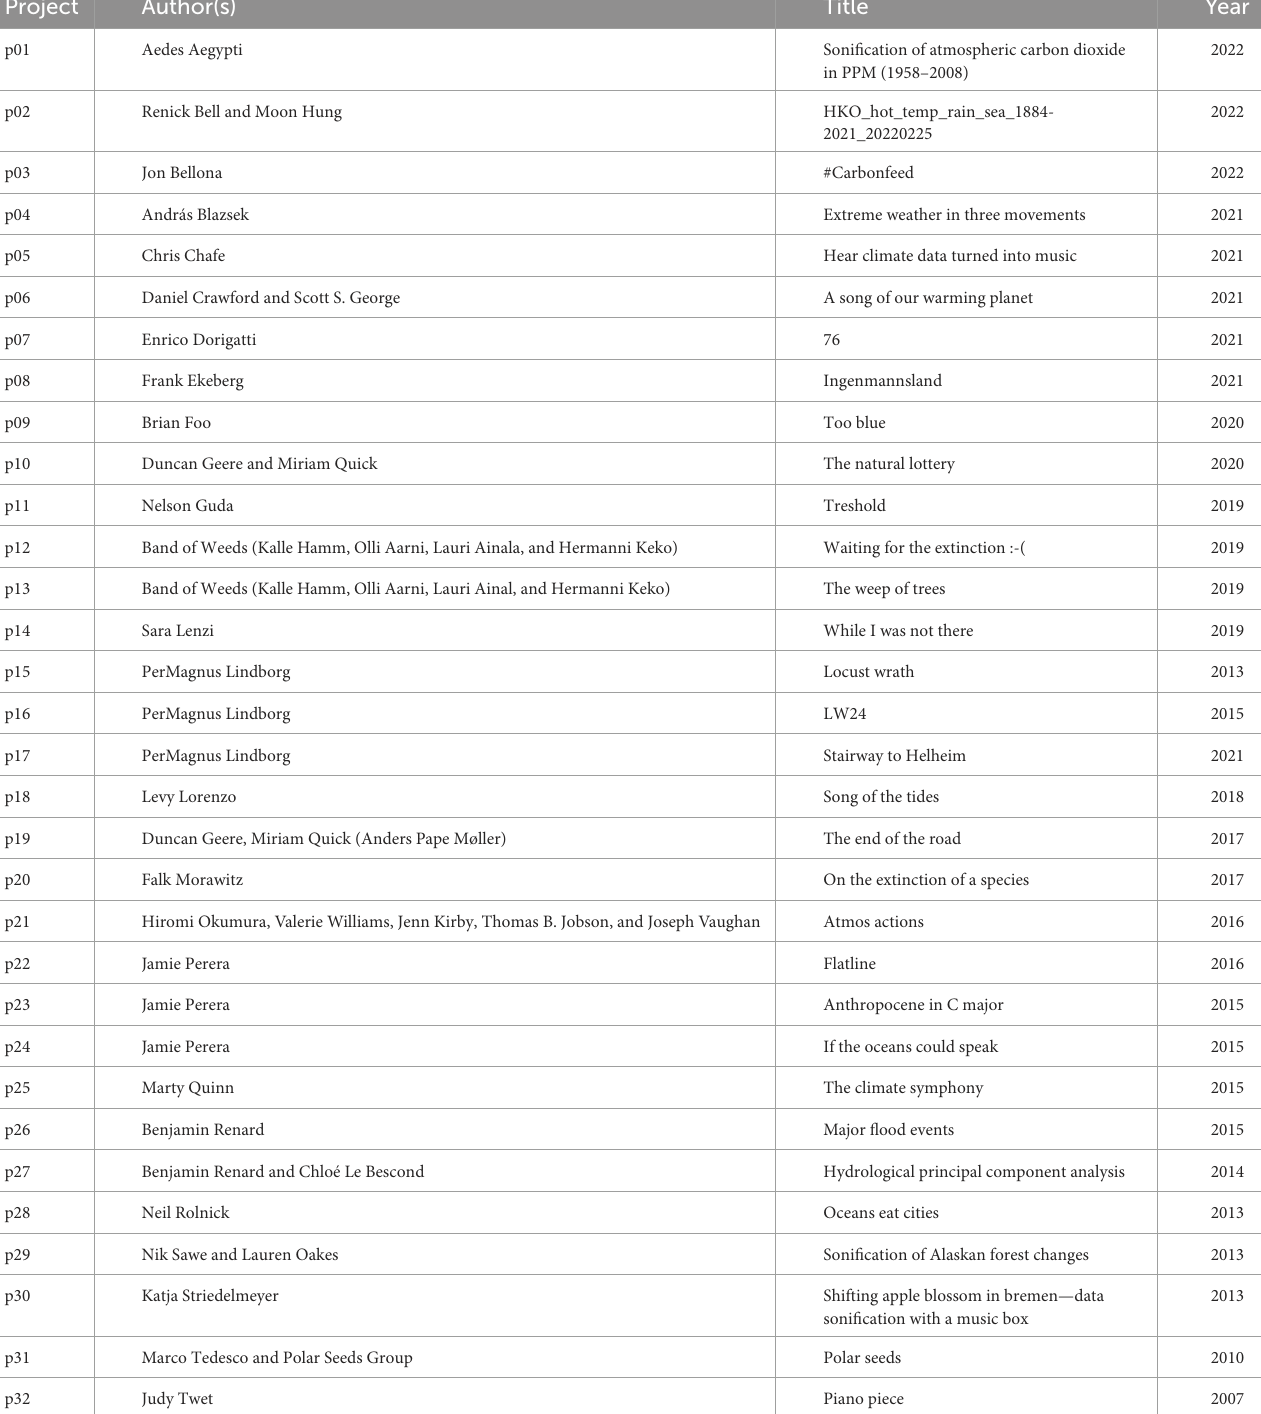
TABLE 1 Overview of the 32 climate data projects included in the